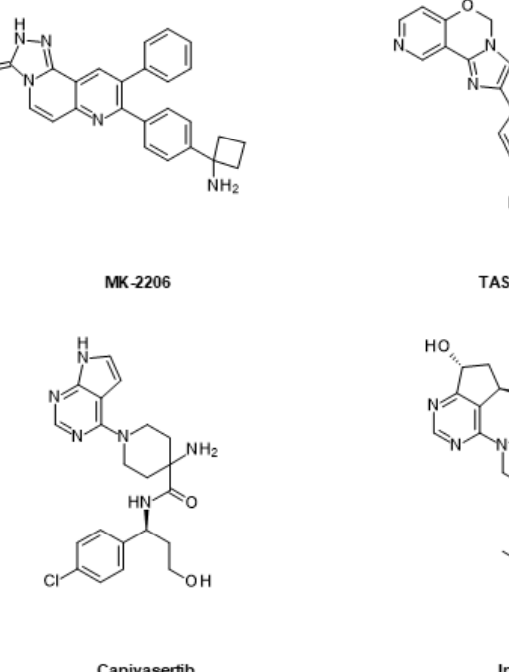
Figure 8. Macrocyclic allosteric mTOR inhibitors.